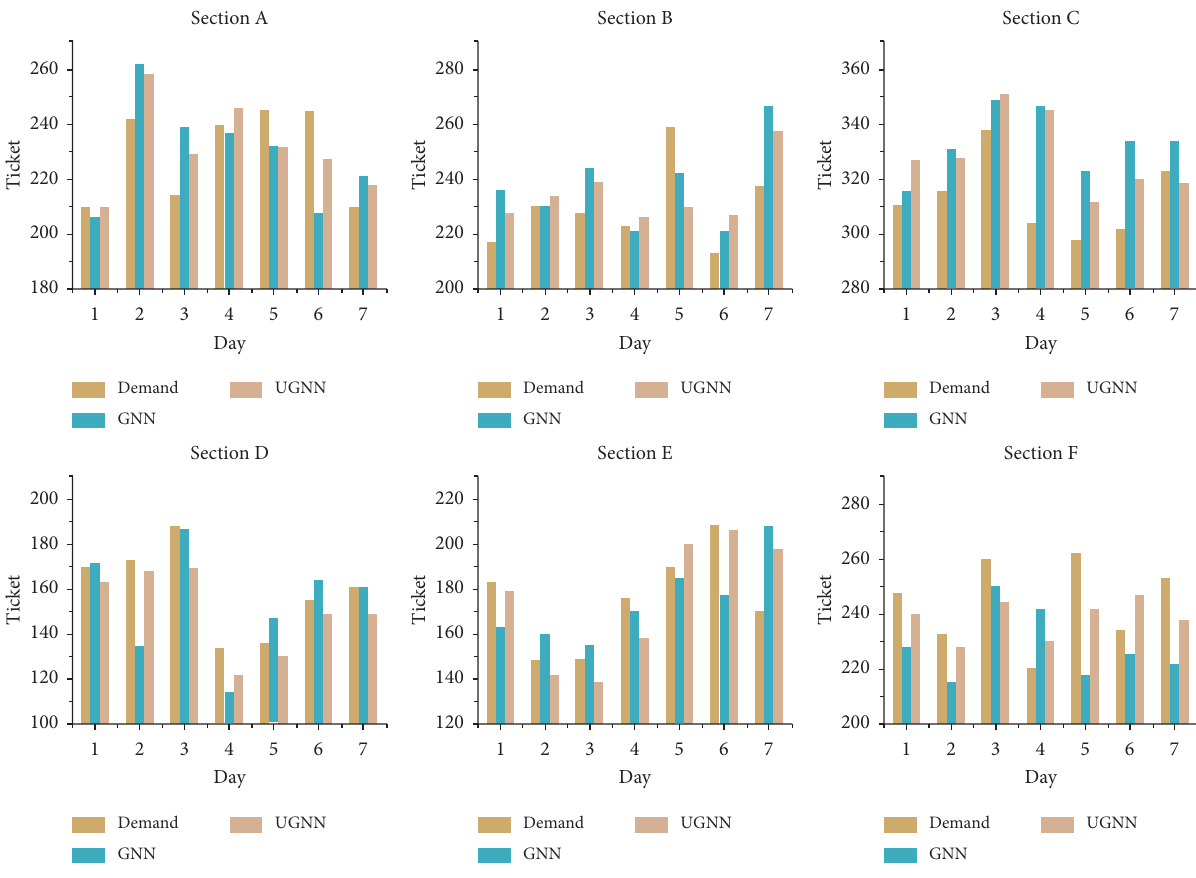
Figure 10: Comparisons of GNN and UGNN prediction results.